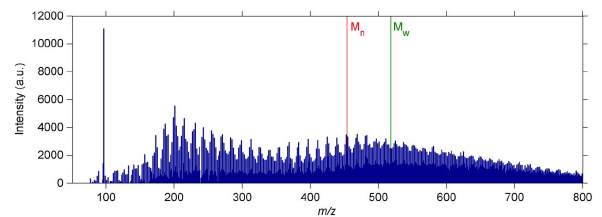
Figure 7. Average spectrum of compounds measured in the negative APCI mode on 29 July 2 Fig. 7. Average spectrum of compounds measured in the negative 2010 13:00-14:30 (UTC+2) during a period influenced by the severe biomass burning in 3 APCI mode on 29 July 2010, 13:00–14:30LT (UTC + 2), during a central Russia. M n is the number average molecular weight and M w the weight average 4 period influenced by the severe biomass burning in central Russia. molecular weight. 5 M n is the number average molecular weight and M w the weight average molecular